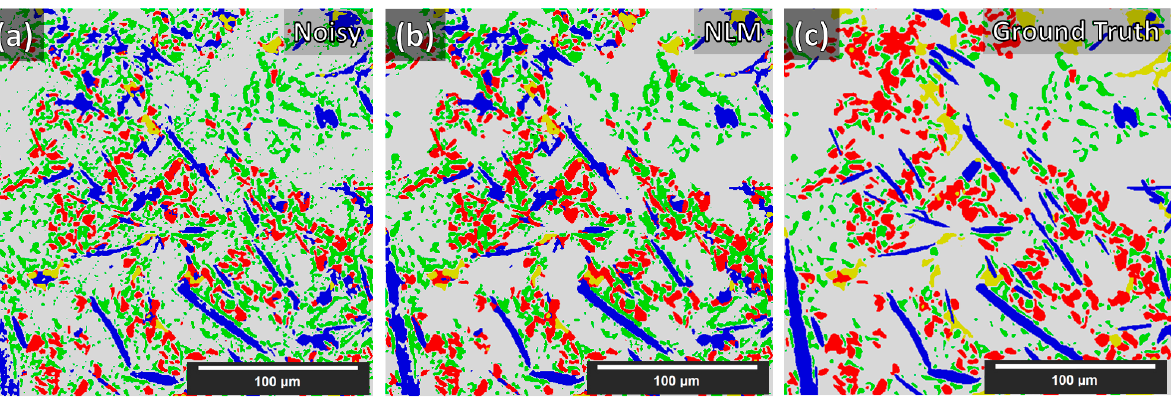
Figure 11. Segmentation maps comparison of the unconditioned (noisy) and NLM-conditioned ex- perimental data for case 4 (i.e., data augmentations + Triple_UNet + MultiView.) Segmentation maps: ( a ) Unconditioned experimental data, ( b ) NLM-conditioned experimental data, ( c ) Ground Truth.